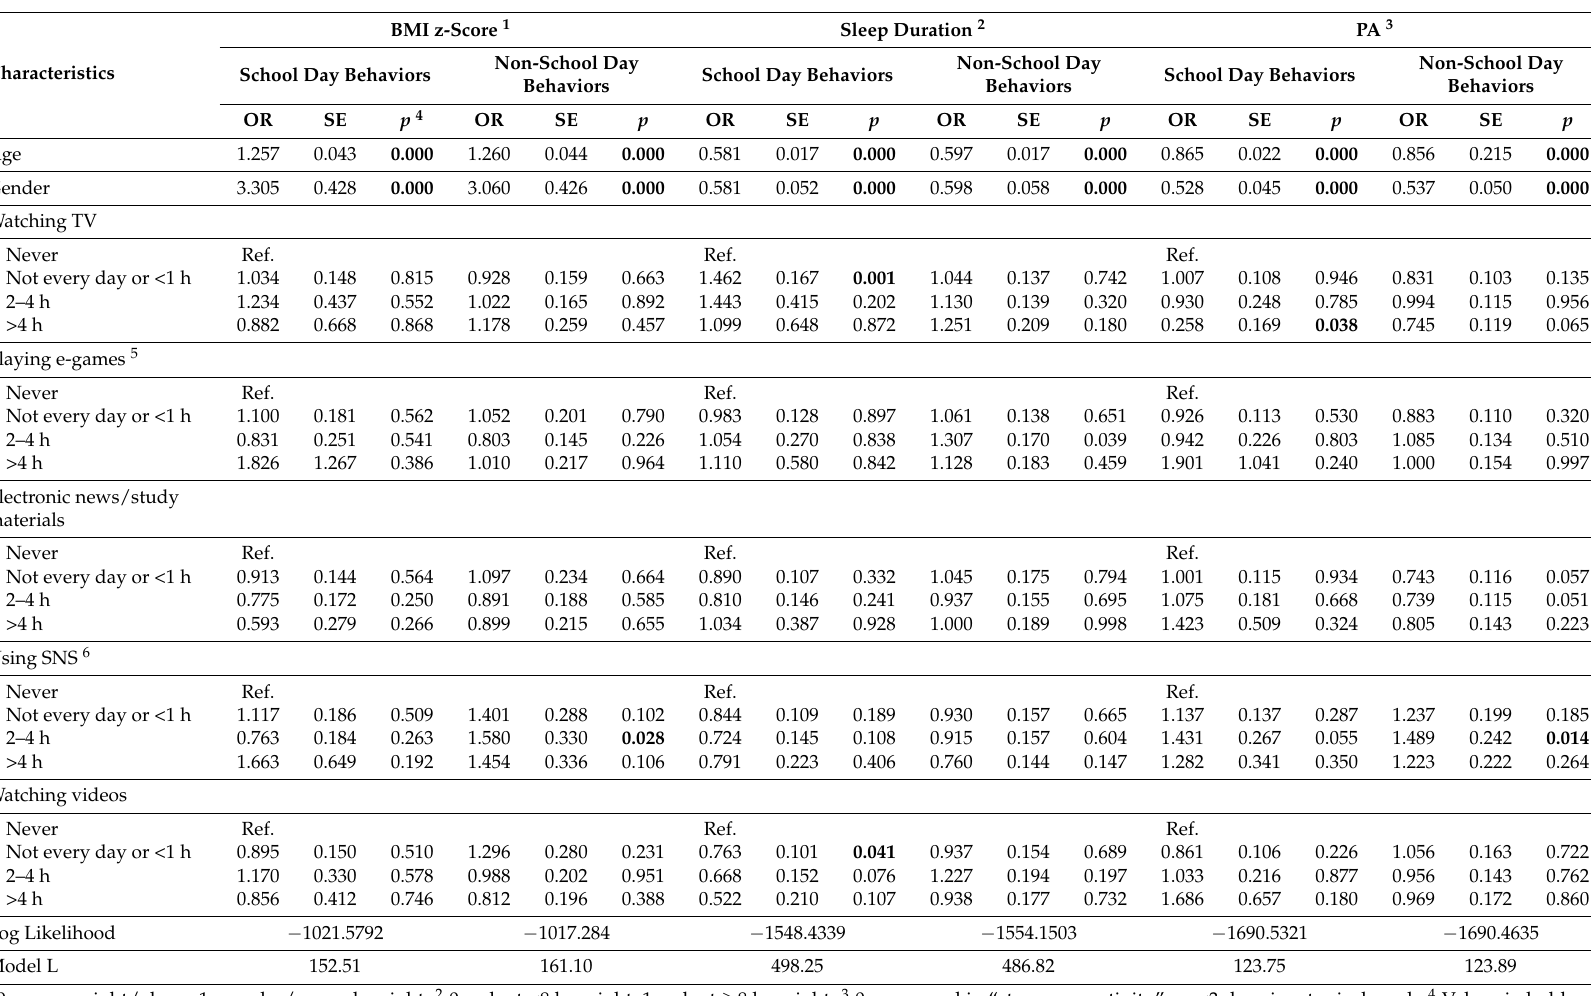
Table 4. The relation of BMI z-score, sleep duration, PA and screen time components ( n =